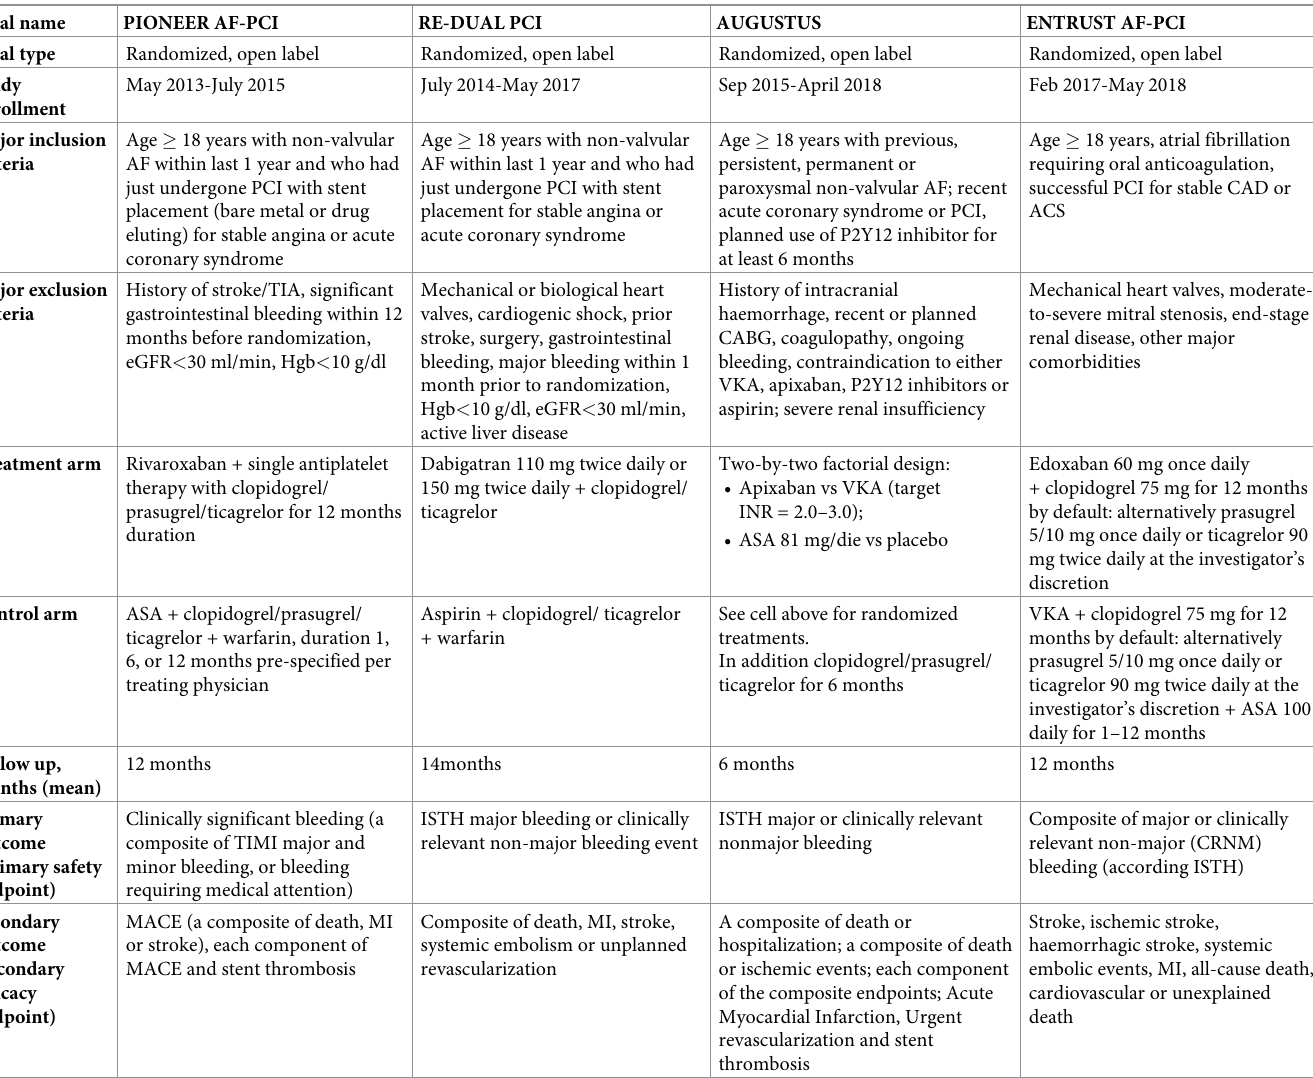
Table 1. Randomized clinical trials assessing DAT including a DOAC versus TAT including VKA in patients with atrial fibrillation undergoing